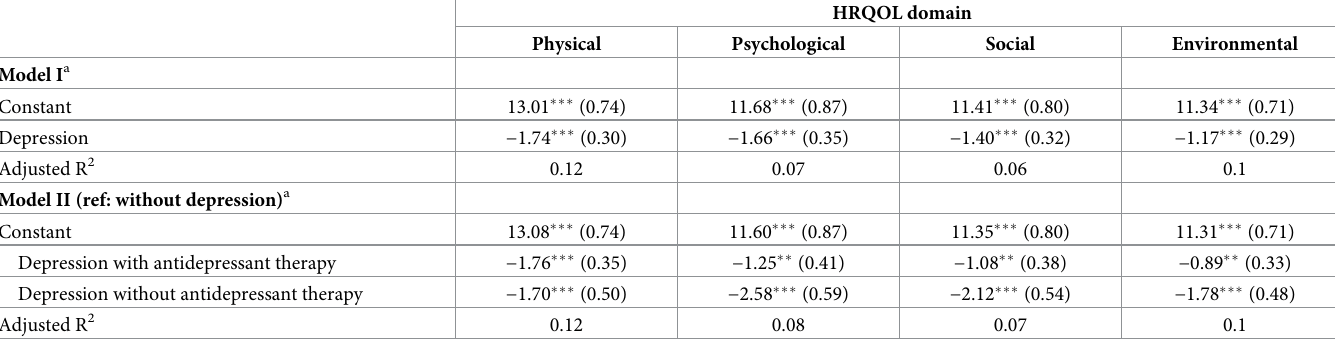
a after controlling for the demographic characteristics and history of sexually transmitted